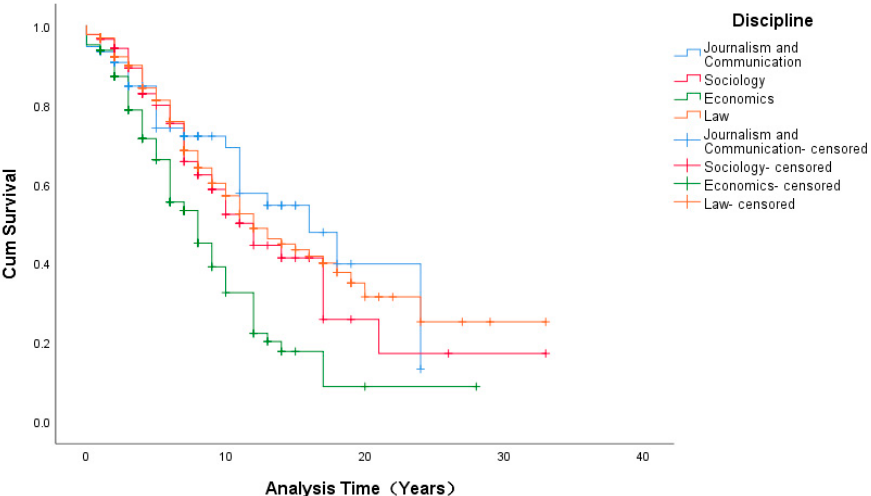
Figure 3. Survival Functions of the Mean of the Covariates from Assistant to Associate (Disciplines).